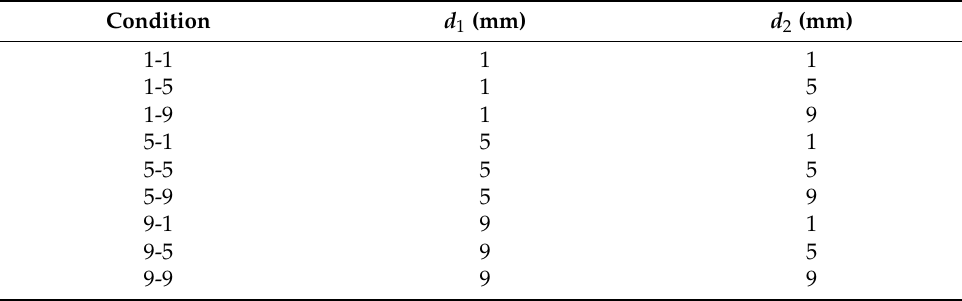
Figure 8. Types of slip shape at inlet.